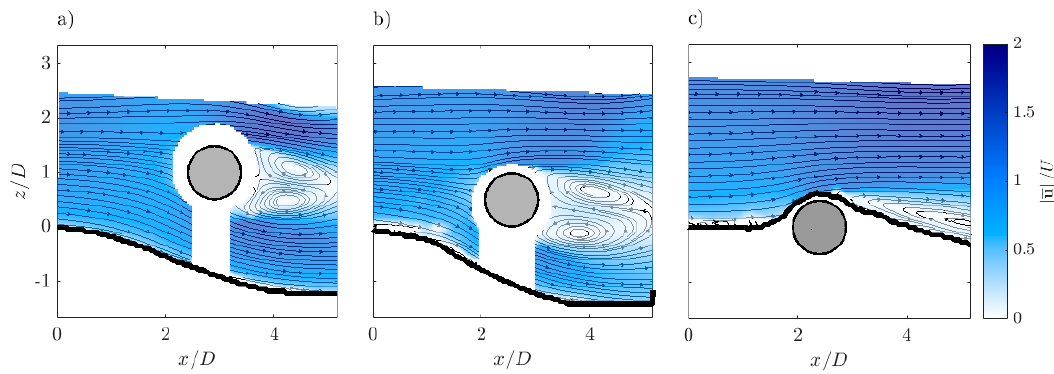
Figure 5. Dimensionless ensemble-averaged velocity fields on a vertical plane in ( a ) Run 1, ( b ) Run 2 and ( c ) Run 3.